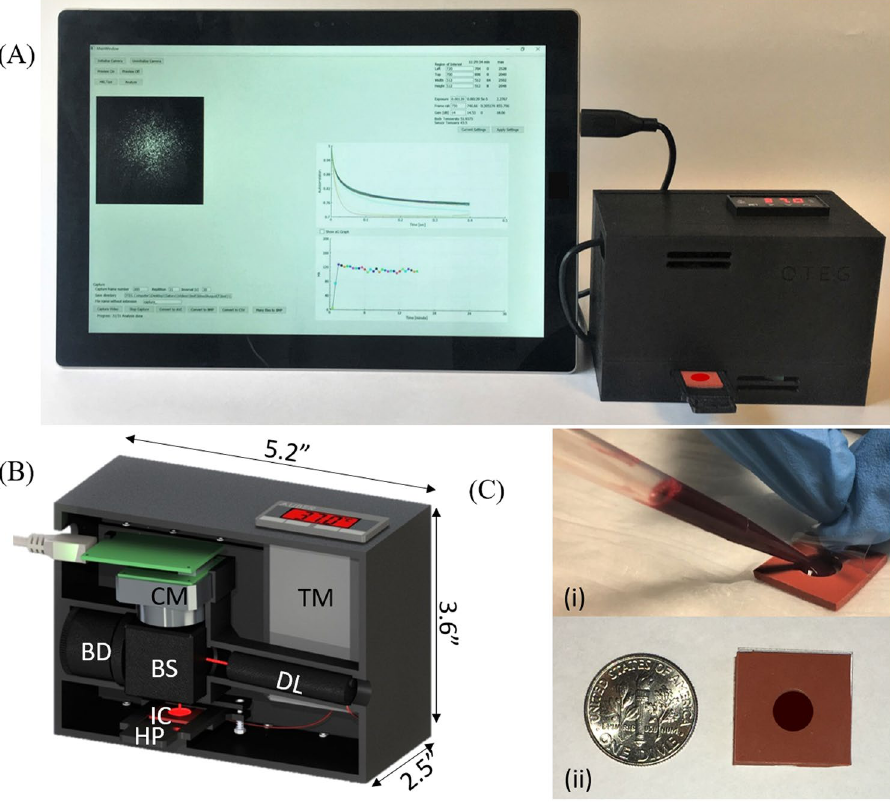
Figure 1. LSR-based coagulation sensor: (A) Photograph of the hand-held sensor and compatible Window surface tablet interface, (B) Computer aided diagram of the optical and mechanical device configuration. Light from a 690 nm diode laser (DL) was focused (spot size 100 μ m) by a lens on the disposable test cartridge (IC) containing 40 μ L of thromboplastin-activated whole blood. Cross-polarized laser speckle patterns were acquired at 180° back-scattering geometry via a beam-splitter (BS) using a USB CMOS camera (CM) equipped with an imaging optics consist of a linear polarizer, a 500 µ m aperture and an f 9 mm focusing lens. Beam dump (BD) dumps the laser beam transmitted through the beam splitter (BS). A miniature heating element (HP), temperature controller (TM) and a custom cartridge tray was incorporated within the hand-held sensor. The captured speckle patterns were transferred to a Microsoft Surface TM tablet computer for further processing. ( C ) Inexpensive test cartridges were fabricated by laser cutting a silicone base with a transparent polycarbonate film overlay to sample a drop of whole blood (40 μ